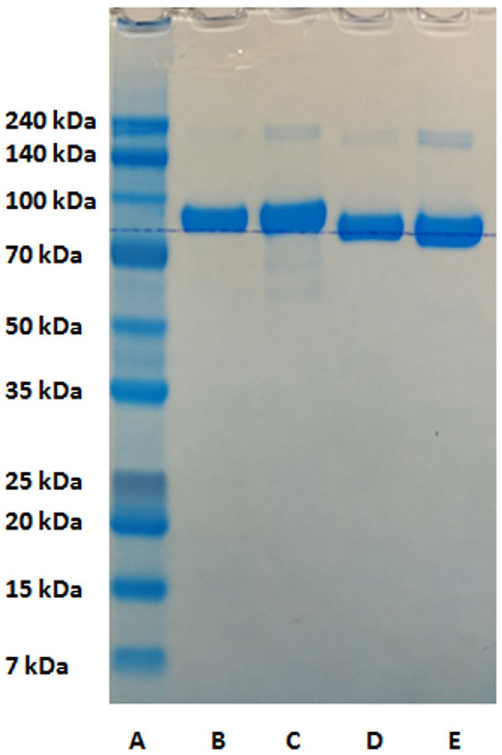
Figure 3. SDS-PAGE of the Fe-bLTF complex, where ( A )—protein markers, ( B ) and ( C )—native bLTF and Fe-bLTF complex prepared in reduced mode, ( D ) and ( E )—native bLTF and Fe-bLTF complex prepared in non- reduced mode. The full-size electropherogram is presented in Fig. S. 4 of supplementary